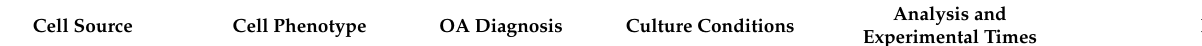
Table 1. Summary of preclinical in vitro